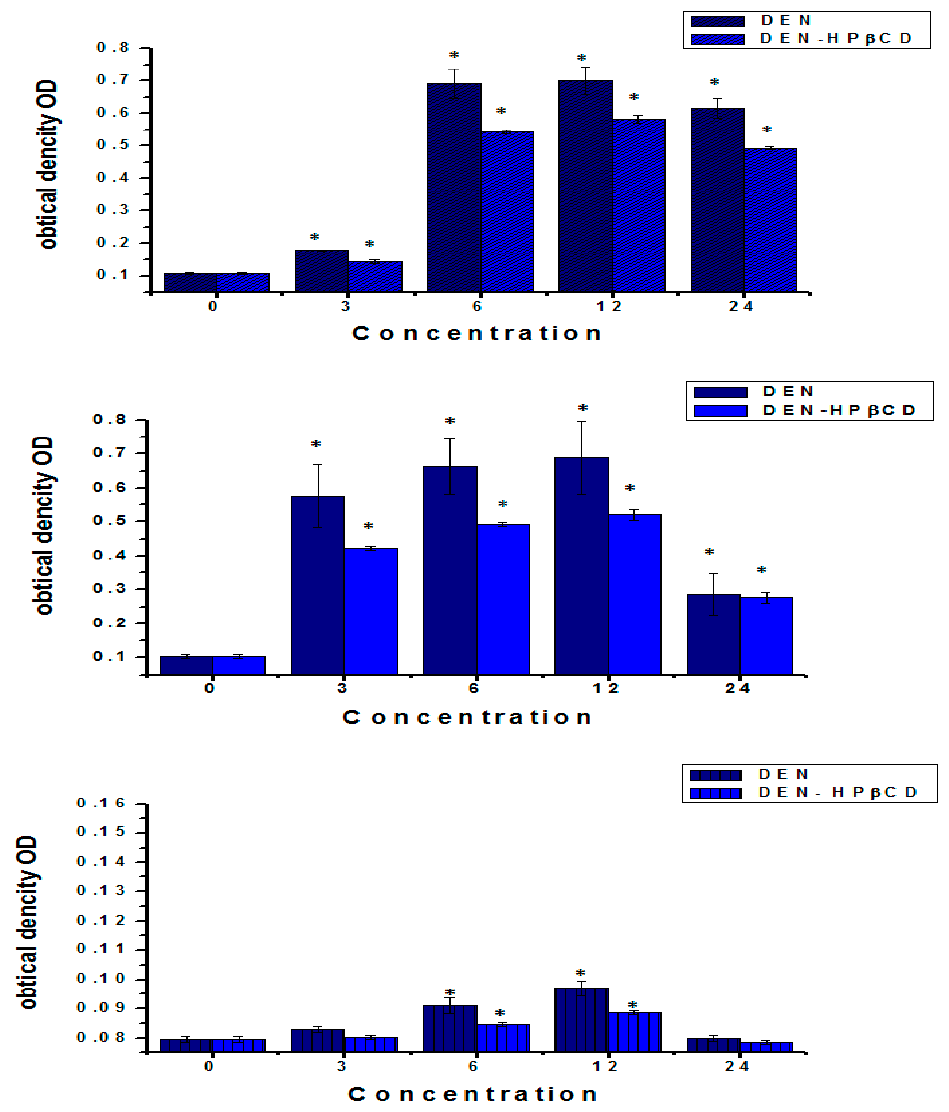
Figure 7. Cont. Figure 7.